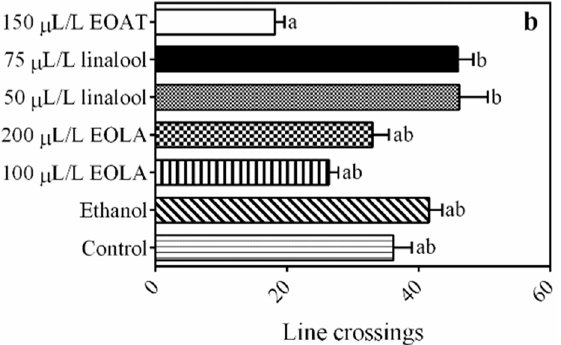
Figure 3. Tank exploration of H. bonariensis exposed to control, ethanol, and 75 µ L/L of A. triphylla